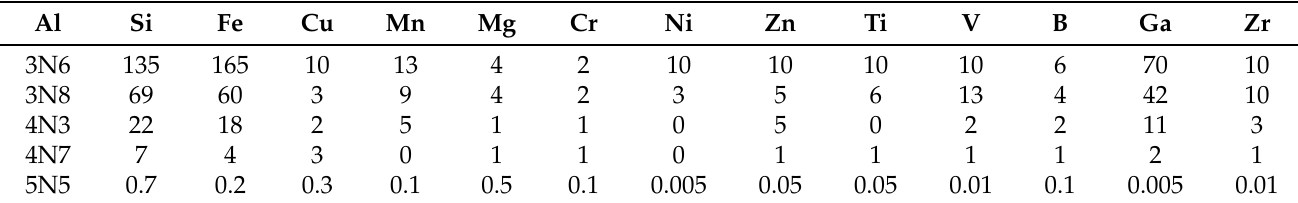
Table 7. Typical obtained aluminum purity grade and its impurity content—in ppm, data from [47].